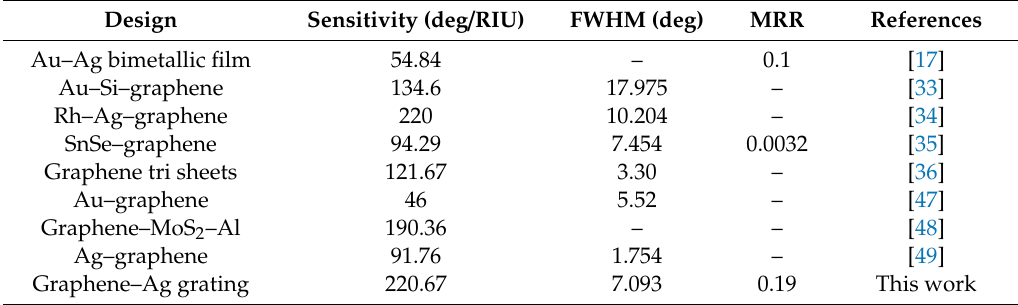
Table 1. Comparison of di ff erent sensing